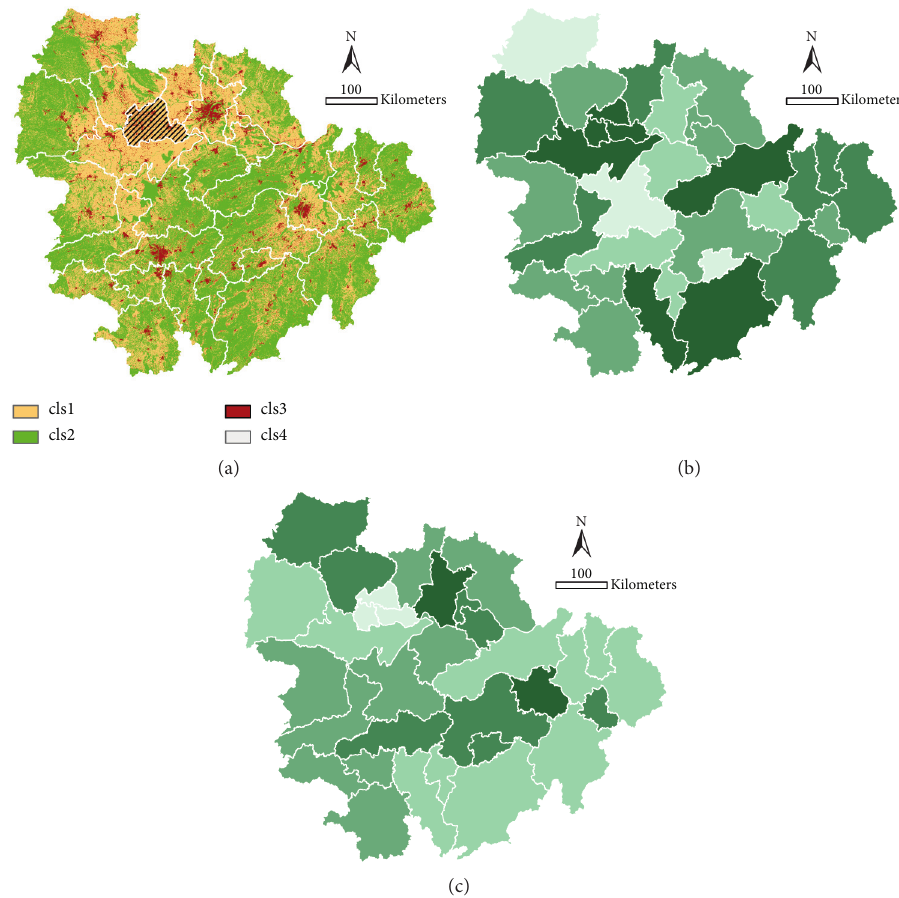
Figure 5: Spatial distribution of (a) LANDCOVER; (b) CONTAG; (c)